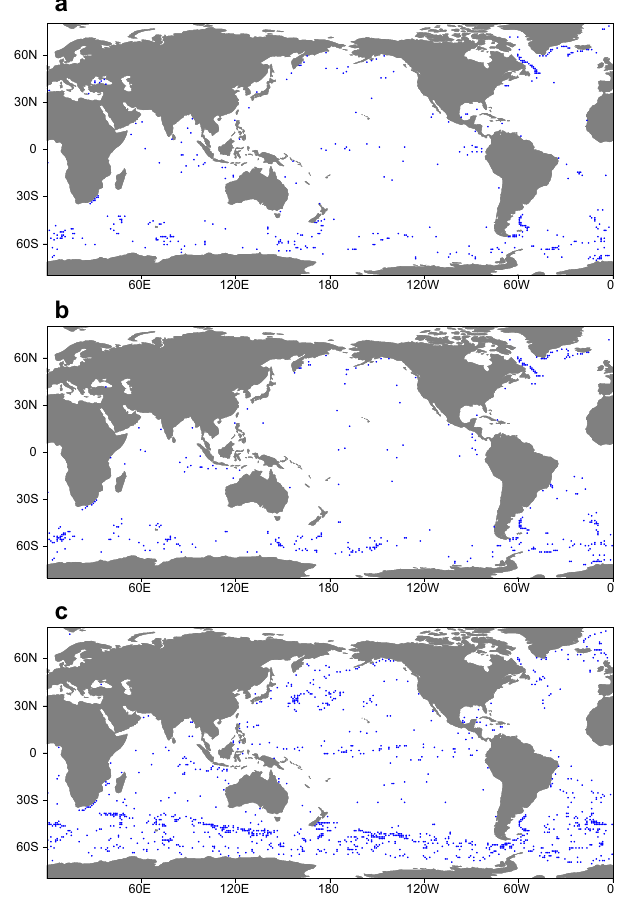
Fig. 1 | Global distribution of well-modelled areas for models, 1.415% for ECCO2(a), 1.325% for OFES(b), and 3.843% for CMEMS(c). The well-modelled areas are highlighted by blue